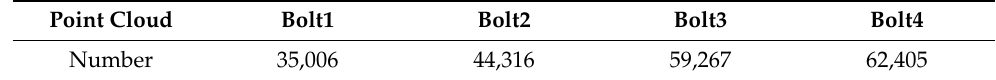
Table 2. Bolts and its number of points.